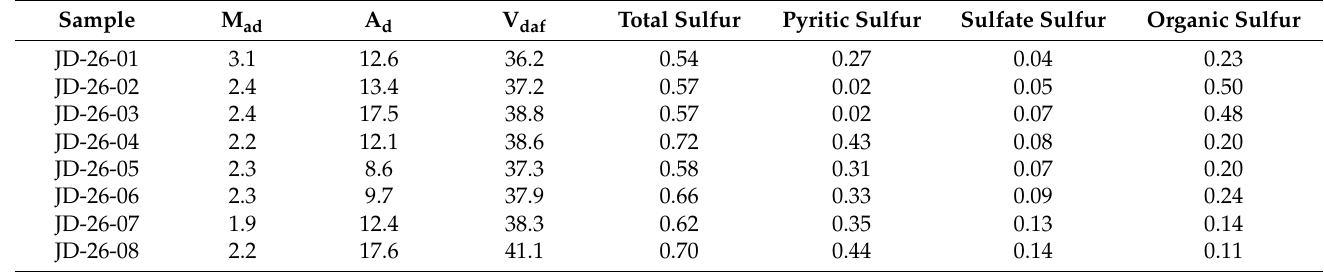
Table 1. Proximate analysis and sulfur contents (%) of coals from Junde